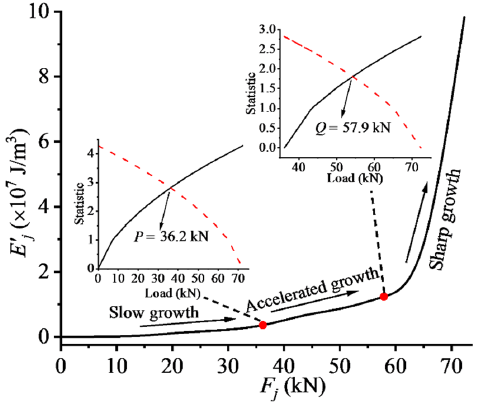
' E F − curve and M–K statistic curves: P = 36.2 kN and Q = j j